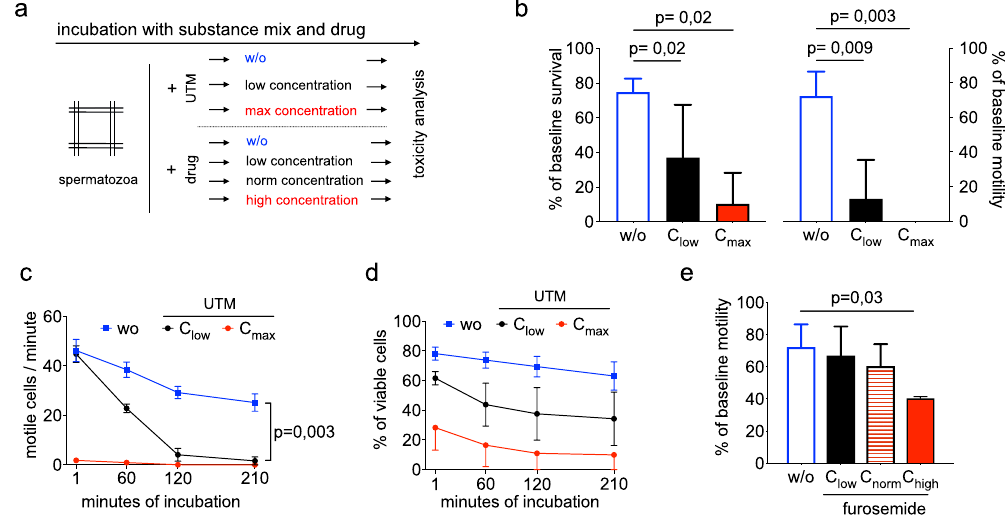
Figure 3. Toxicity detection of substance mix and drug. (a) Workflow to measure effects of a substance mix and drugs. Uremic toxin mix was applied in C max (highest concentration measured in uremic patients) and in C low (1:16 dilution of C max ). Following substances and concentrations were applied within the UTM: Uric acid (C max : 147 µ g/ml; C low : 9.19 µ g/ml), xanthine (C max : 3.44 µ g/ml; C low : 0.22 µ g/ml), uridine (C max : 32.6 µ g/ml; C low : 2,04 µ g/ml) and uracil (C max : 0,45 µ g/ml; C low : 0.03 µ g/ml). (b) Survival (left) and motility (right) were analyzed after 120 minutes of incubation on a minimum of 3 donors. (c) Motility analysis of five experimental rounds. Cells from three different donors. ( d ) Frequency of viable cells over time on cells from three donors. In ( c ) and ( d ) SEM are shown. ( e ) Furosemide was applied to the cell model to test for motility. Incubation of 120 minutes was performed.P-value indicates significance